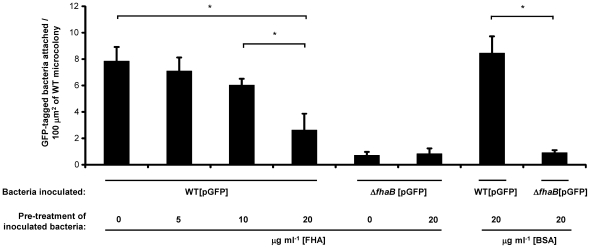
Association to biofilms of B. pertussis planktonic cells pre-treated with exogenous FHA.GFP-tagged planktonic bacteria of the WT (BPSM) and ΔfhaB (BPGR4) strain pre-incubated with SS medium, various concentrations of purified FHA or BSA (20 µg ml−1) followed by incubation for 4 h with 24-h-old WT biofilms. GFP-expressing bacteria attached to biofilms were visualized by acquiring multi-channel (transmitted light and fluorescence) CLSM images. The numbers attached bacteria was determined by examining multi-channel images using ImageJ in conjunction with the ITCN plug-in. The data are the means ± standard deviations of the numbers of GFP-tagged bacteria per 100 µm2 of preformed biofilm microcolony derived from the analysis of twenty four microscopic fields on four coverslips per condition. An asterisk indicates significant differences between the conditions compared (P value <0.05; Student's t-test).